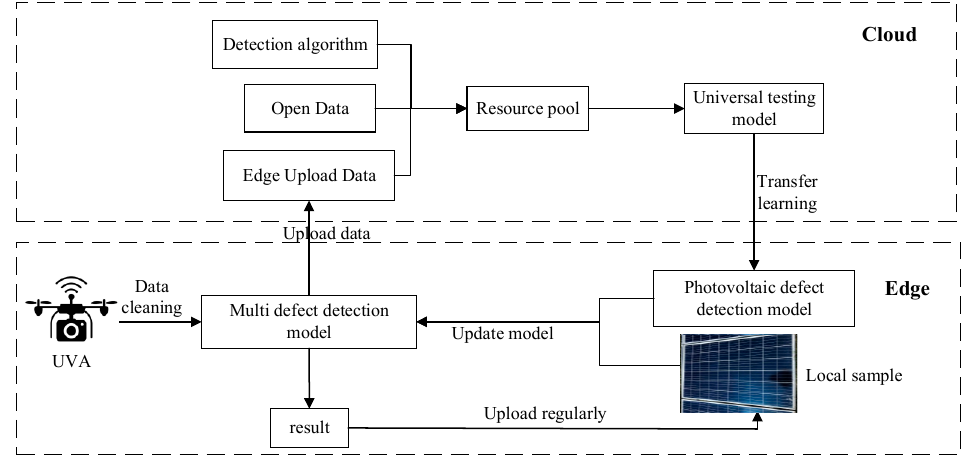
Figure 1. Overall framework design.